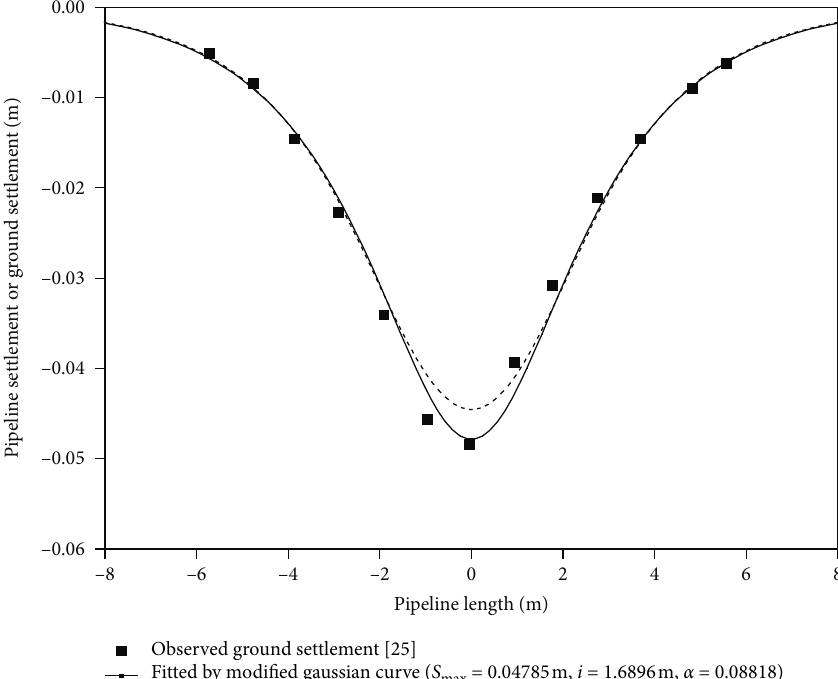
Figure 5: Pipeline and ground settlements.